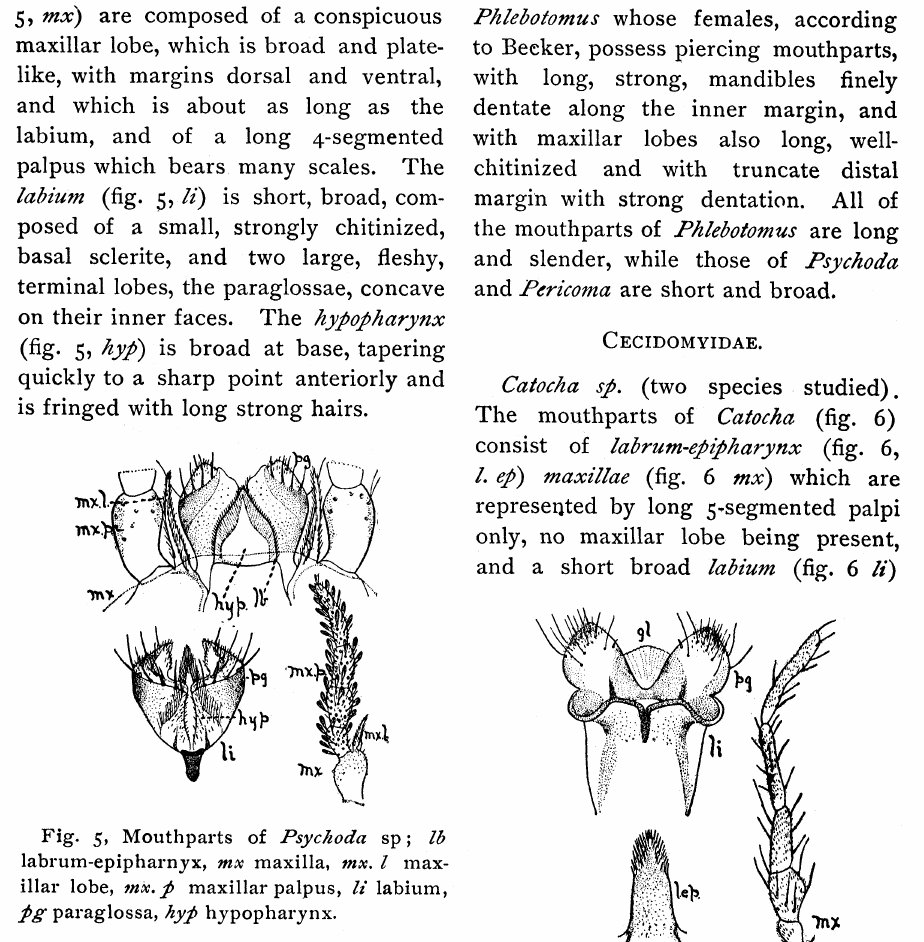
Fig. 6, Mouthparts of Catocha sp; l. e/